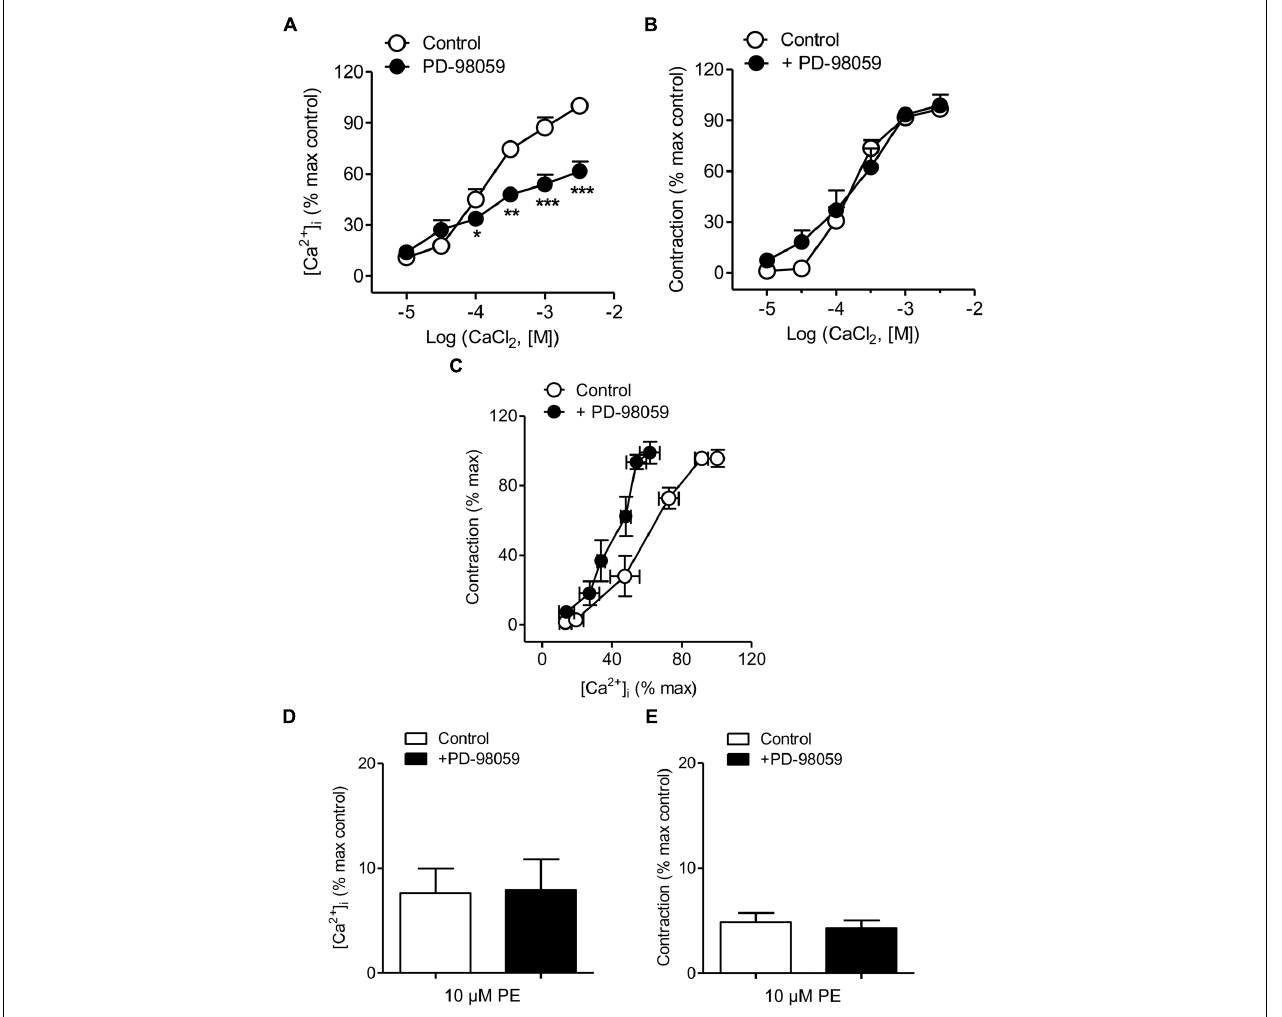
FIGURE 4 | ERK-MAPK inhibition reduced Ca 2 + entry but not vasoconstriction and increased Ca 2 + sensitization elicited by α 1 -adrenoceptor activation. (A,B) Average effects of the ERK-MAPK inhibitor PD-98059 (3 µ M) on the increases in [Ca 2 + ] i (A) and contraction (B) elicited by cumulative addition of CaCl 2 in endothelium-denuded arteries kept in a nominally Ca 2 + -free medium and stimulated by 10 µ M PE. (C) Effect of PD-98059 on the [Ca 2 + ] i -contraction relationship for 10 µ M PE in mesenteric resistance arteries and (D,E) on the increases in [Ca 2 + ] i and contraction elicited by 10 µ M PE in Ca 2 + -free PSS. Results are expressed as a percentage of control maximal responses. Values are means ± SEM of n = 7 arteries (one from each animal). ∗ P < 0.05, ∗∗ P < 0.01, ∗∗∗ P < 0.001 vs. control.